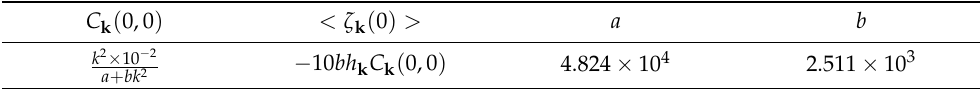
Figure 1. The initial ( a ) and evolved day 10 ( b ) QDIA [ ζ ( t )] , ( c ) MIC X = 0 [ ζ ( t )] , ( d ) MIC X = 1 2 [ ζ ( t )] , ( e ) MIC X = 1 [ ζ ( t )] , and ( f ) ensemble of DNS Rossby wave streamfunction in non-dimensional units. Multiply values by Table 1. Initial conditions used in DNS and closure calculations.